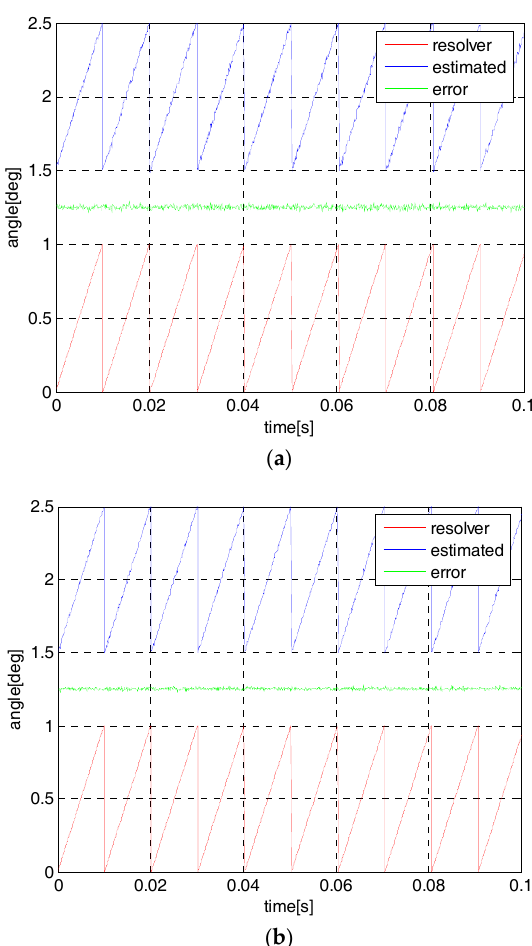
Figure 8. The simulated angle and its estimation at 3000 rpm by using one ‐ step observer ( a ) and two ‐ step observer ( b ).